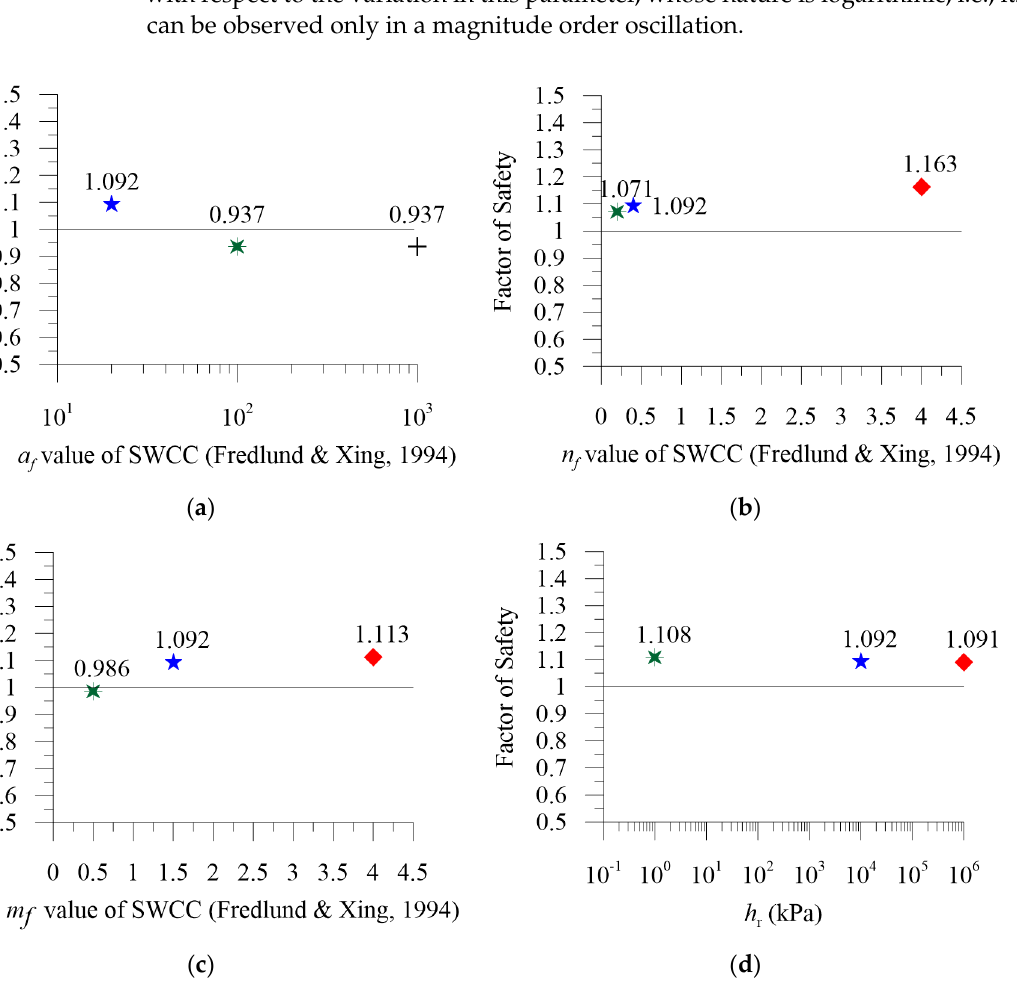
f ; ( b ) n f ; ( c ) m f ; ( d ) h